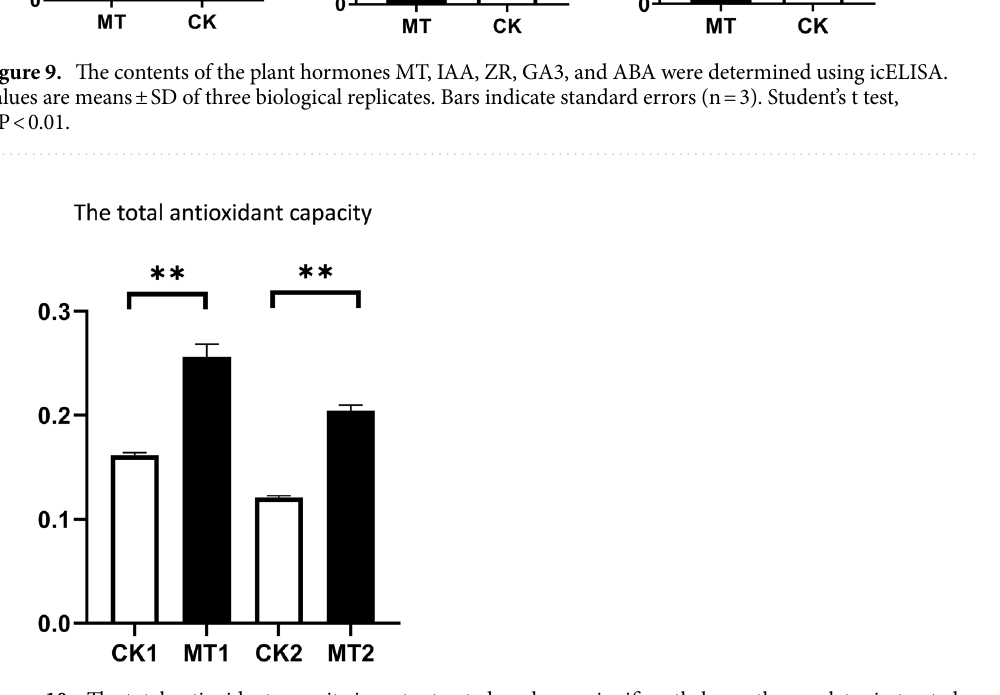
Figure 10. The total antioxidant capacity in water treated seeds was significantly lower than melatonin treated seeds. Values are means ± SD of three biological replicates. Bars indicate standard errors (n = 3). Student’s t test, **P <